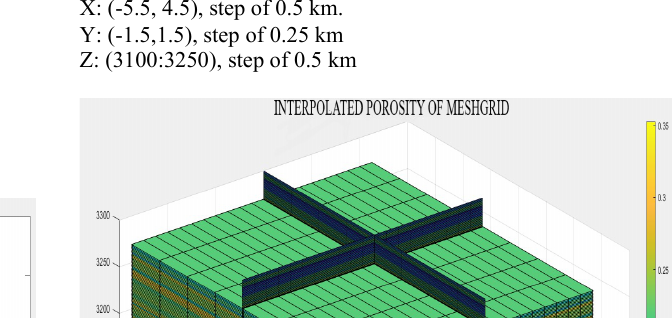
Figure 5. has the following specifications.